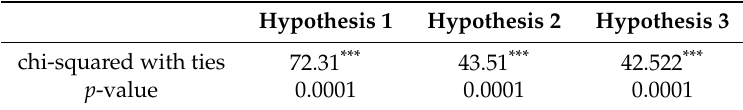
Table 5. Kruskal–Wallis rank sum test.